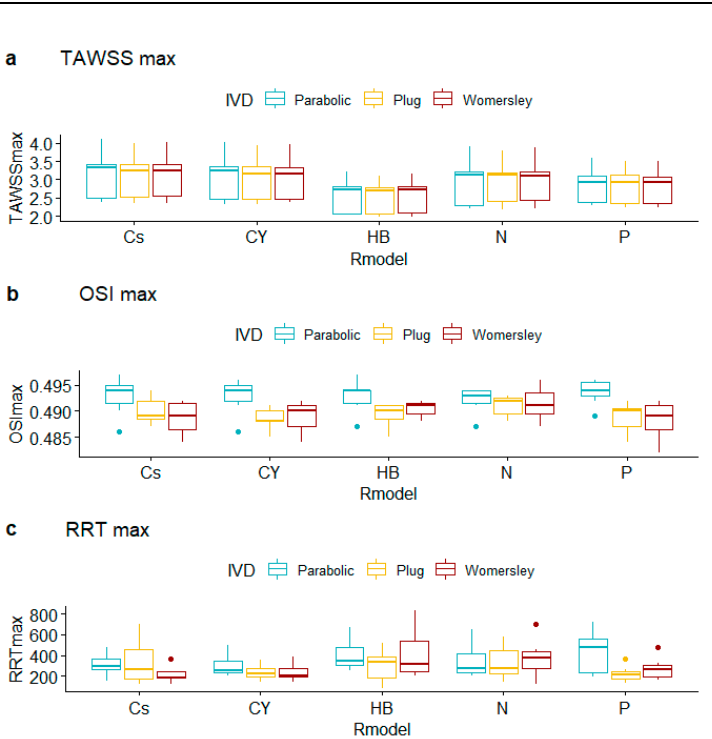
Figure 8. Boxplots of observed maxima of hemodynamic variables for alternative rheological models and inlet velocity distributions.